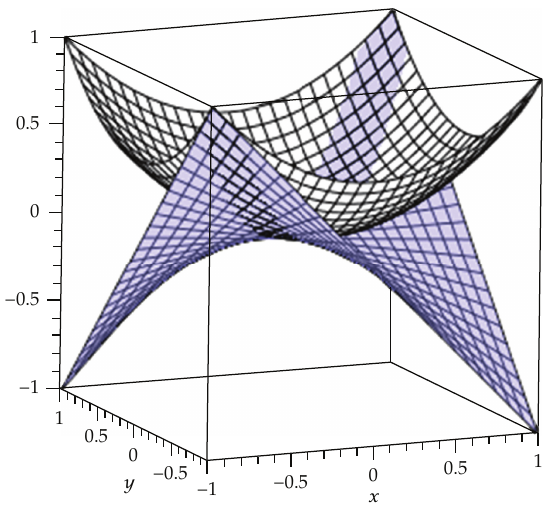
Figure 1: f (cid:3) x,y (cid:4) (cid:2) xy and h ∗